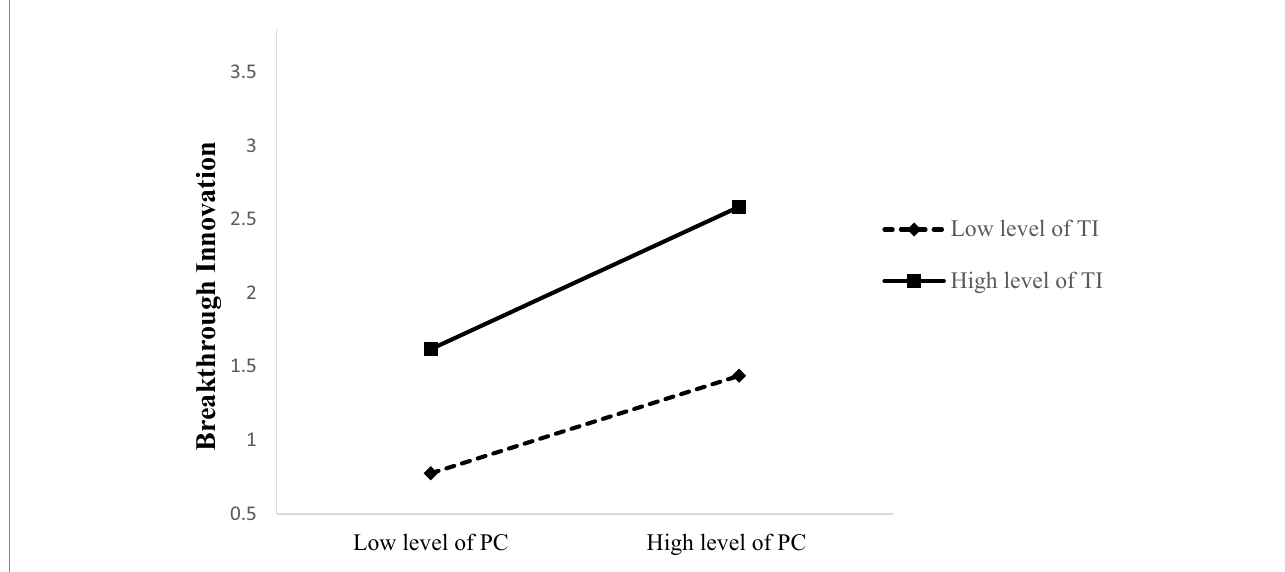
FIGURE 2 The moderating effect of task interdependence. PC, psychological capital; TKS, Tacit knowledge sharing; TI, Task interdependence.